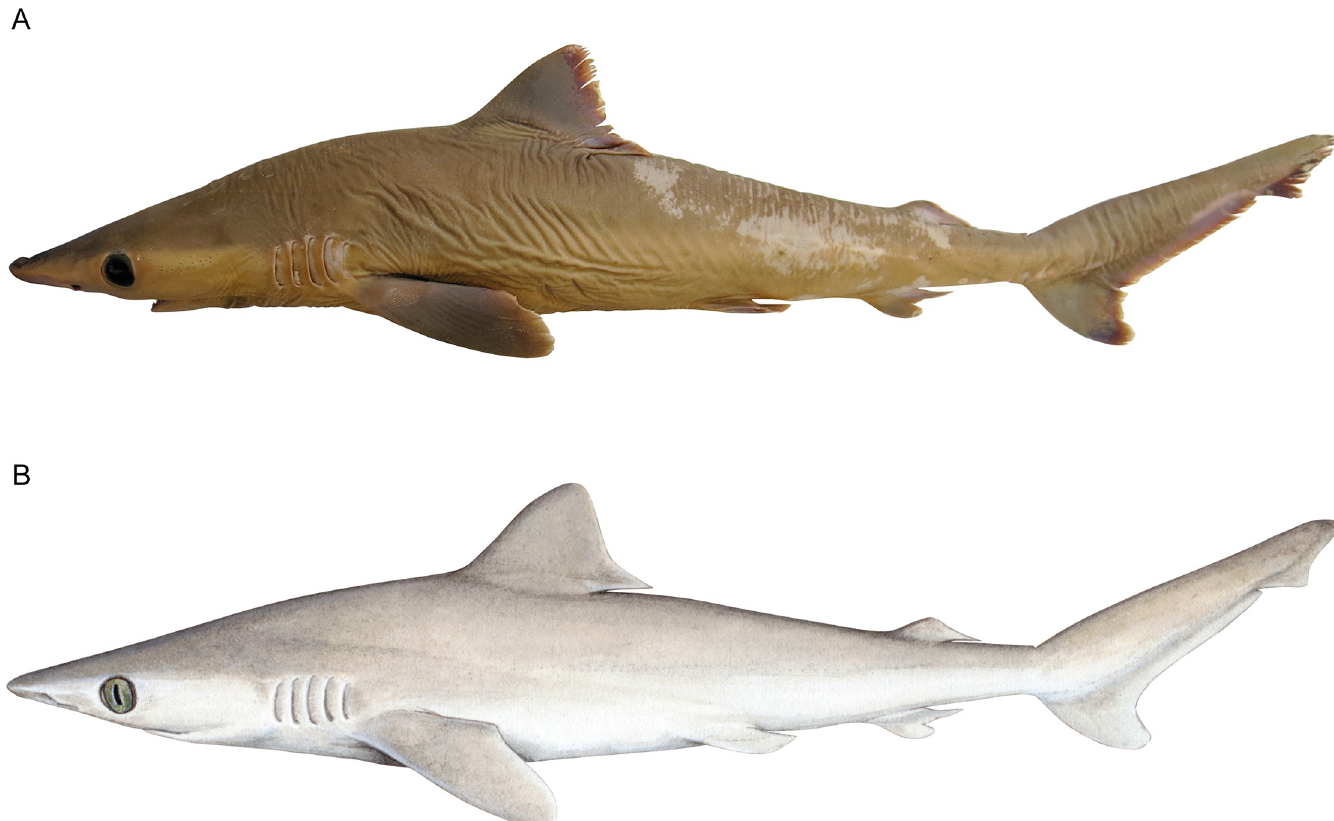
Fig 1. Lateral view of Carcharhinus obsolerus sp. nov. (NMW 61463; female holotype 433 mm TL). A. Preserved specimen; B. Painting by Lindsay Marshall (www.